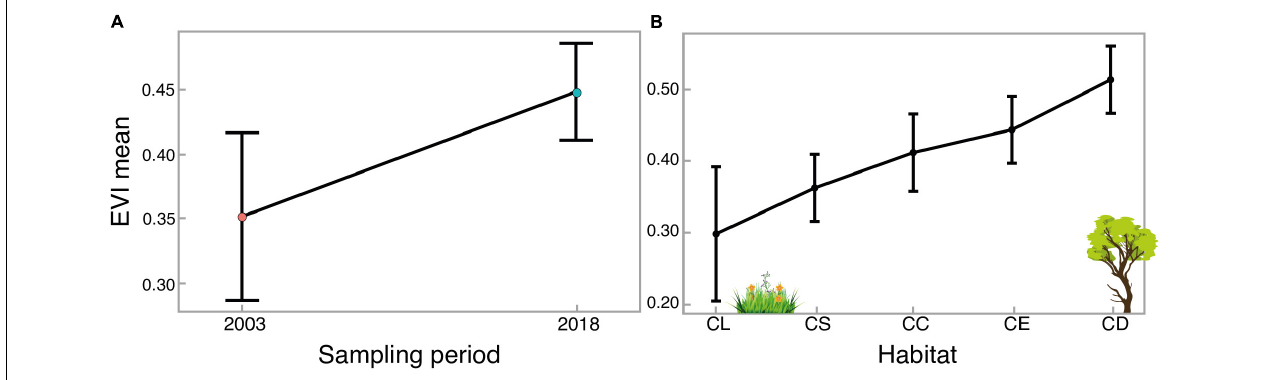
FIGURE 5 | Means of enhanced vegetation index (EVI) and standard deviation estimated by linear models for (A) sampling periods and (B) Cerrado habitats. The habitats are: CL: “ campo limpo ”; CS: “ campo sujo ”; CC: “ campo cerrado ”; CE: “ cerrado sensu stricto” ; and CD: “ cerradão .”